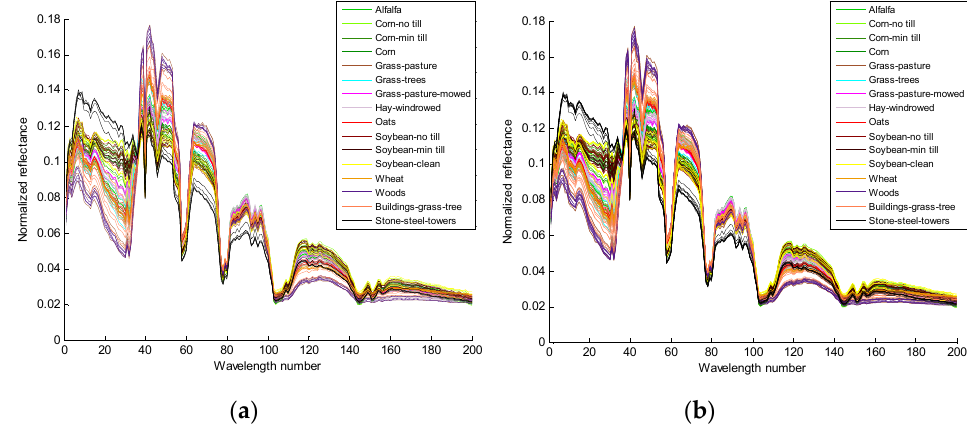
Figure 4 The spectral reflectance of the training samples in the Indian Pines data Figure 4. The spectral reflectance of the training samples in the Indian Pines data: ( a ) the training samples (the training (a) The training samples (the training samples includes 16 classes, each class randomly takes 5 training samples include 16 classes, each class randomly takes 5 training samples, and each color represents a class), and ( b ) the 3 times augmented training samples, each color represents a class ） , (b) The 3 times augmented training samples